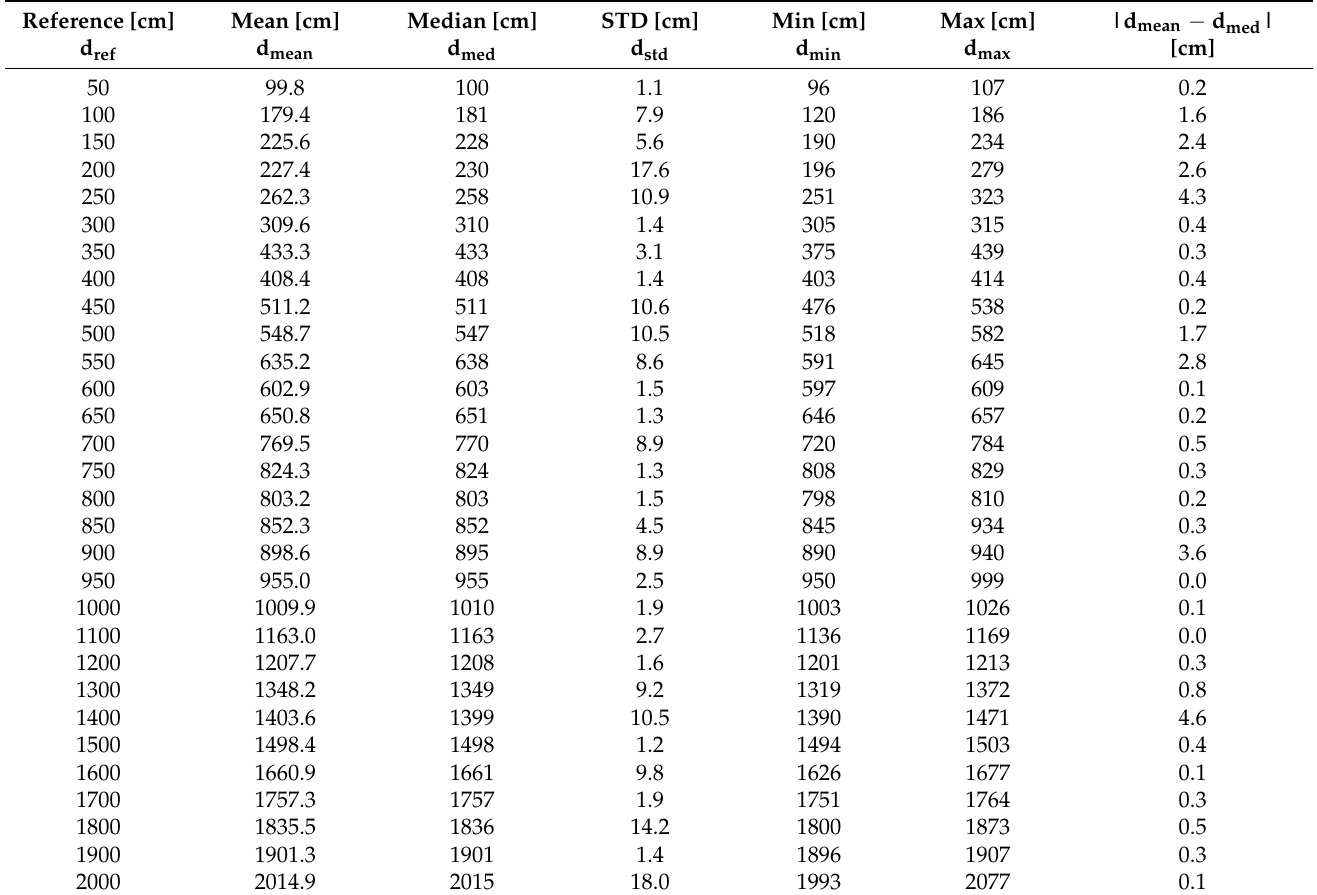
Table 4. Statistical measures of the distance under NLOS